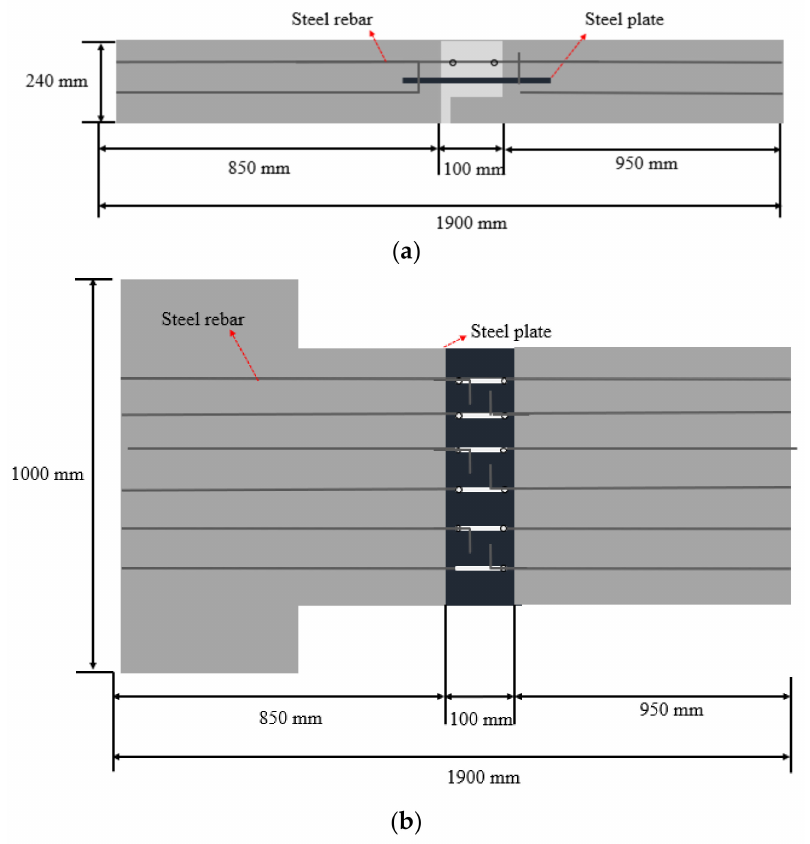
Figure 1. Dimensions of the J100-HB-SP precast bridge deck longitudinal joint. ( a ) Side view. ( b ) Top